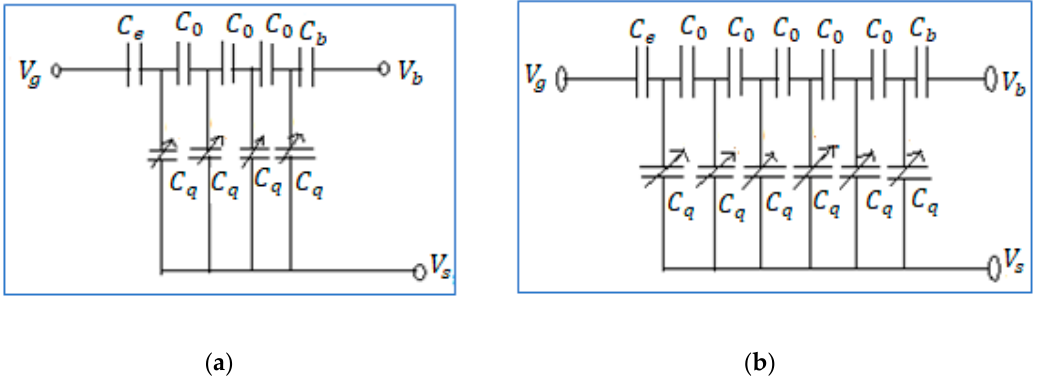
Figure 8. Equivalent capacitance model: ( a ) graphene channel with four layers, ( b ) graphene channel with six layers.